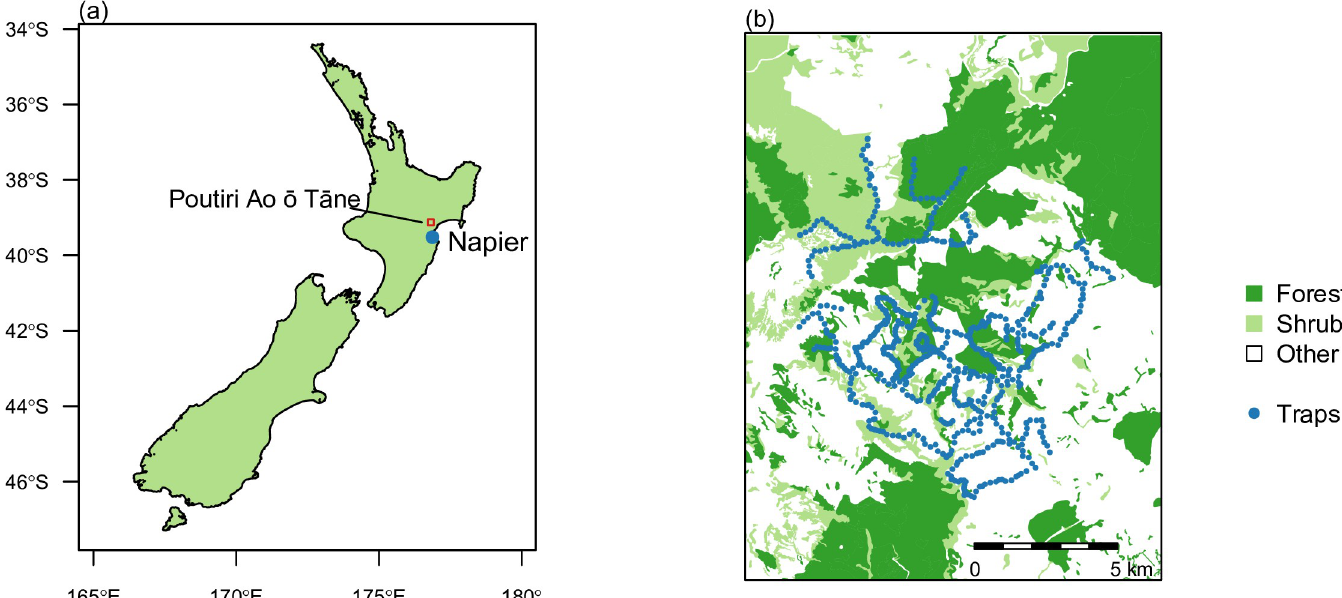
Fig 1. National (a), local (b) maps of the study area. Maps depict (a) the geographical location of Napier city within New Zealand, with the study region indicated by the red square; (b) the Poutiri Ao ō T ā ne trap network, with individual trap sites shown by red dots and patches of forest and shrub land indicated by dark and light green shade